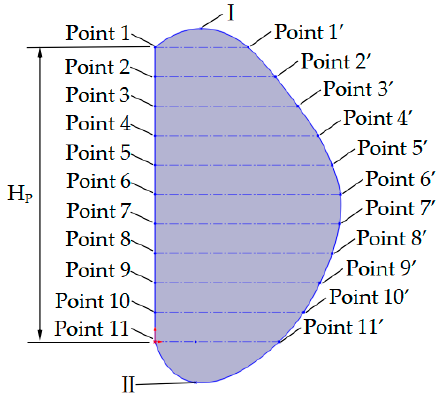
Figure 1. Outer contour curve of Snow pear.